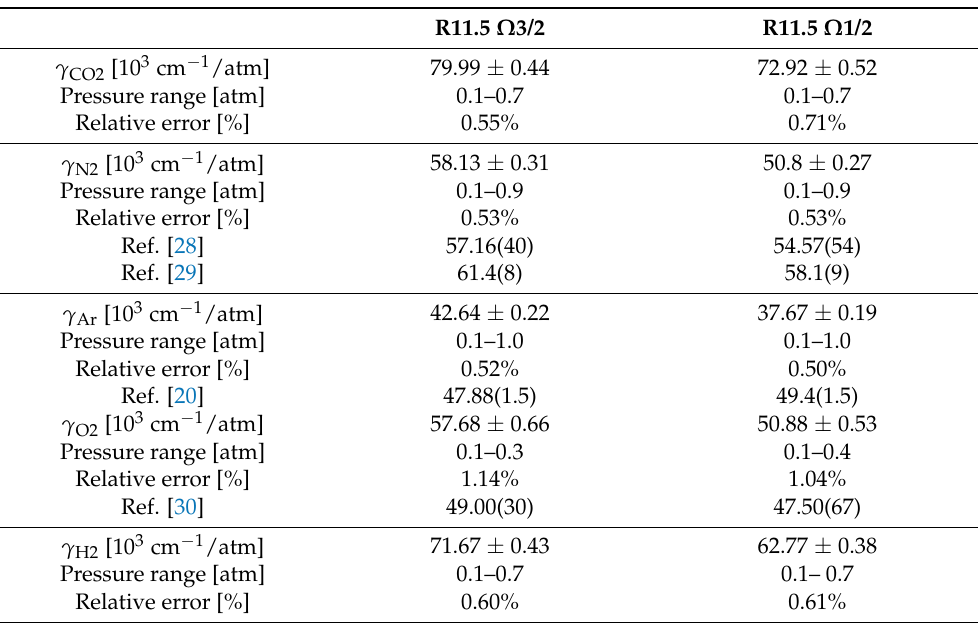
(11.5) absorption lines’ broadening coefficients when combined with N 2 , CO 2 , Ar, H 2 , O 2 , He, and